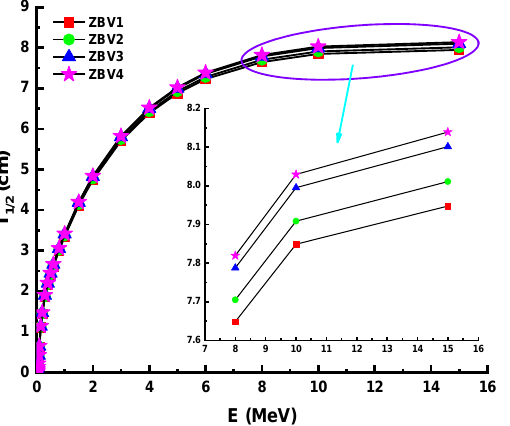
Figure 5. Variation of half-value layer (T 1/2 ) against photon energy for all glasses. However, Figure 5 shows that the HVL values were greater in the mid- as well as the high-energy field. This was attributed to the penetration property of gamma rays and how it changes with higher energy levels. Considering the direct impact of material densities, which were reported as 3.392 g/cm 3 , 3.371 g/cm 3 , 3.339 g/cm 3 , and 3.329g/cm 3 for ZBV1, ZBV2, ZBV3, and ZBV4, respectively, the HVL values were changed in similar order. For example, HVL values of 1.109 cm HVL ZBV1 < 1.121 cm HVL ZBV2 < 1.136 HVL ZBV3 < 1.143 cm HVL